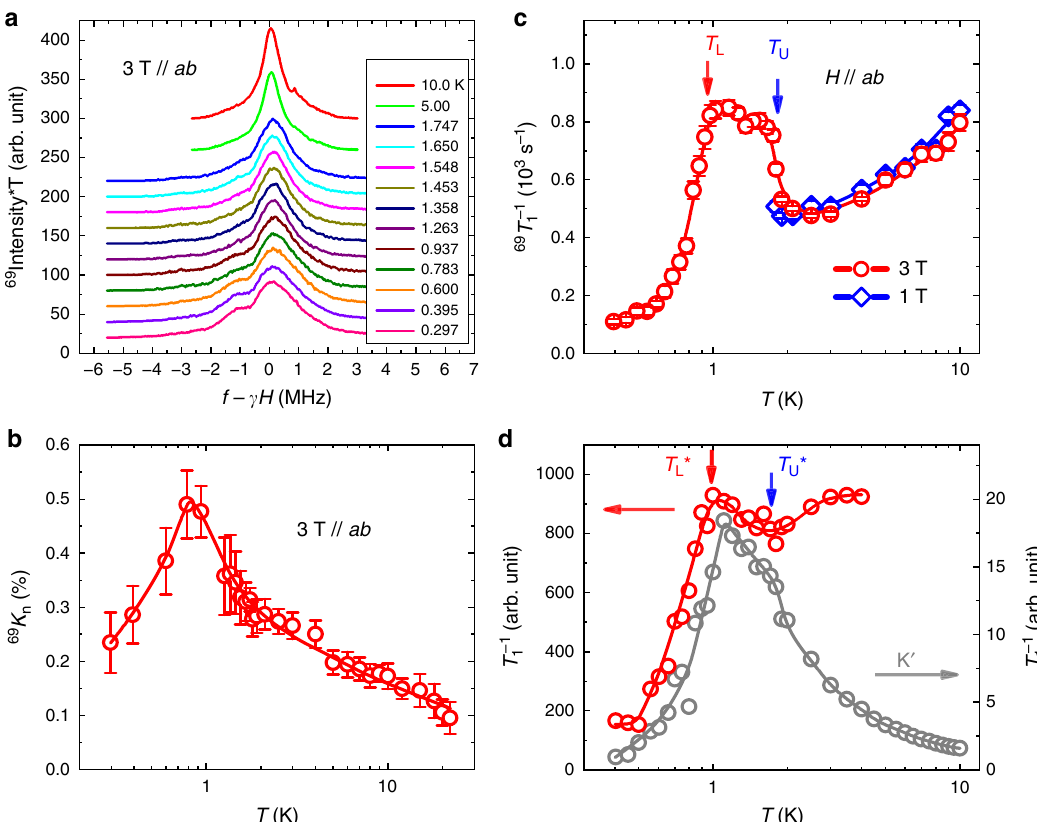
Fig. 2 NMR spectra and spin-lattice relaxation rates of TmMgGaO 4 . a 69 Ga NMR spectra at different temperatures under a 3 T in-plane fi eld, with zero frequency corresponding to γ H = 30.692 MHz. Data are shifted vertically for clarity. At high temperatures, the spectra are roughly symmetric, whereas for T ≤ 2 K, a shoulder-like structure can be resolved on the left side of the main peak. b NMR hyper fi ne shift 69 K temperature, where (cid:1) f is the average frequency of each spectrum. c NMR spin-lattice relaxation rate 1/ 69 T 1 vs. temperature measured under in-plane fi elds of 3 T and 1 T. A plateau-like feature, characterizing strong magnetic fl uctuations, is observed between T L ≃ 0.9 K (lower-BKT transition) and T U ≃ 1.9 K (upper BKT transition). d 1/ T 1 data computed from the dynamical spin – spin correlation function with contributions from all momentum points [c.f., Eq. (3) and see the hyper fi ne form factor in Supplementary Note 2] in the Brillouin zone (left scale) and from K ′ point in the vicinity of the K point (right scale), through large-scale QMC simulations (see “ Methods ” transition. In Fig. 2c, we show the 1/ 69 T 1 obtained under in-plane = 3 T and 1 T, which re fl ects intrinsic spin fl uctuations fi elds μ 0 H with zero out-of-plane fi eld. At 3 T, 1/ 69 T 1 fi rst decreases upon